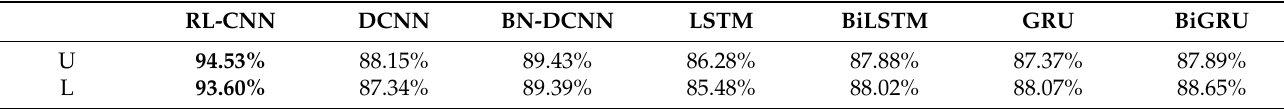
Table 7. The F-score of the upper and lower